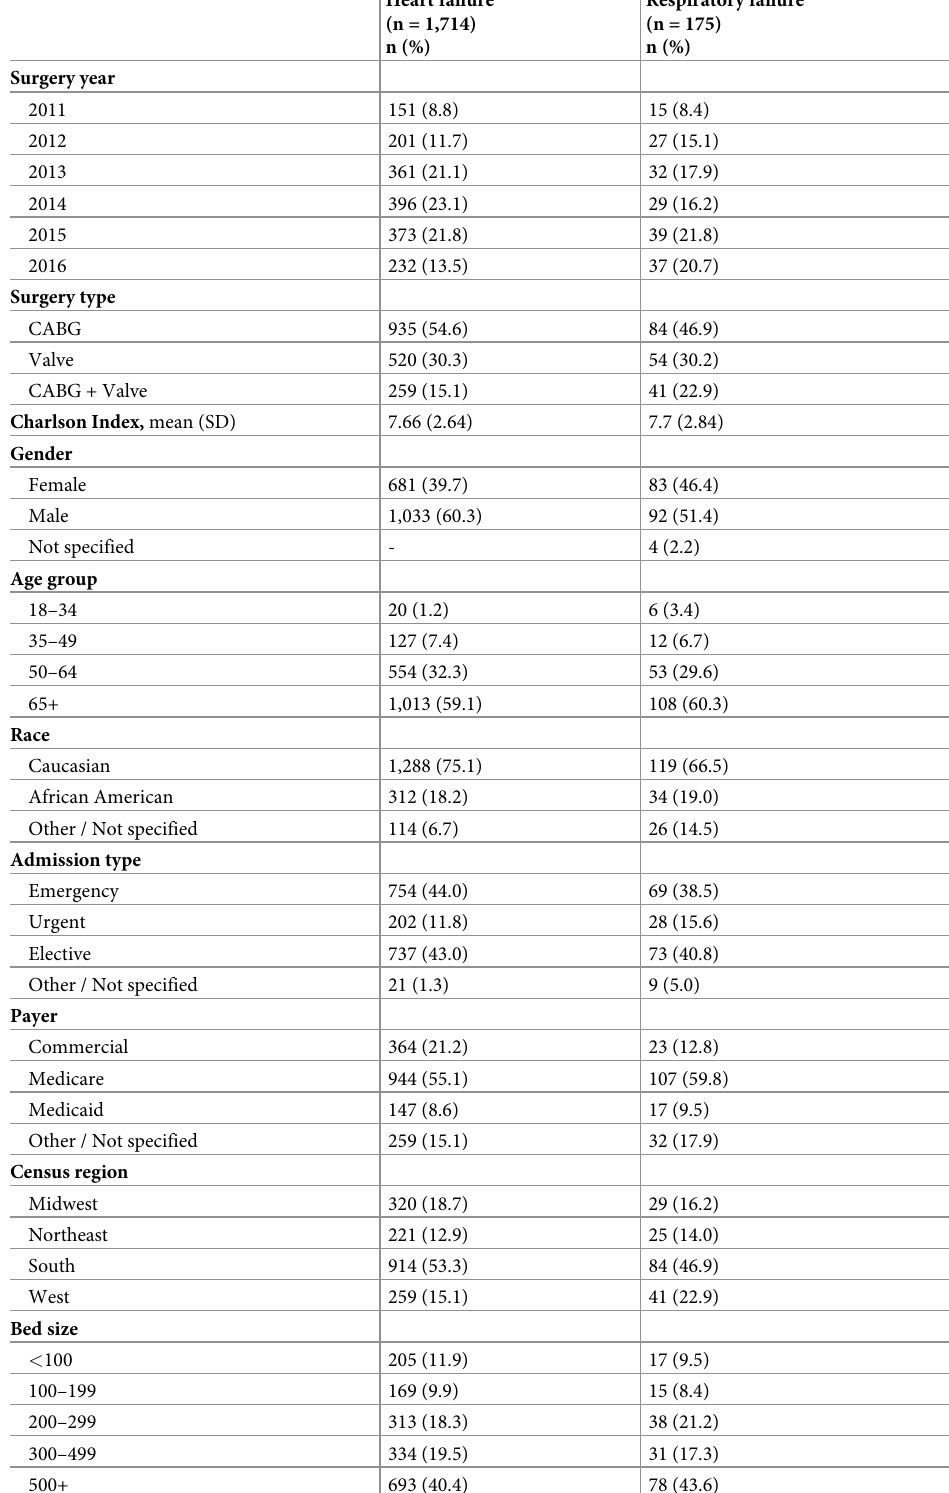
Table 3. Patient and hospital demographics for patients with persistent complications (based on index